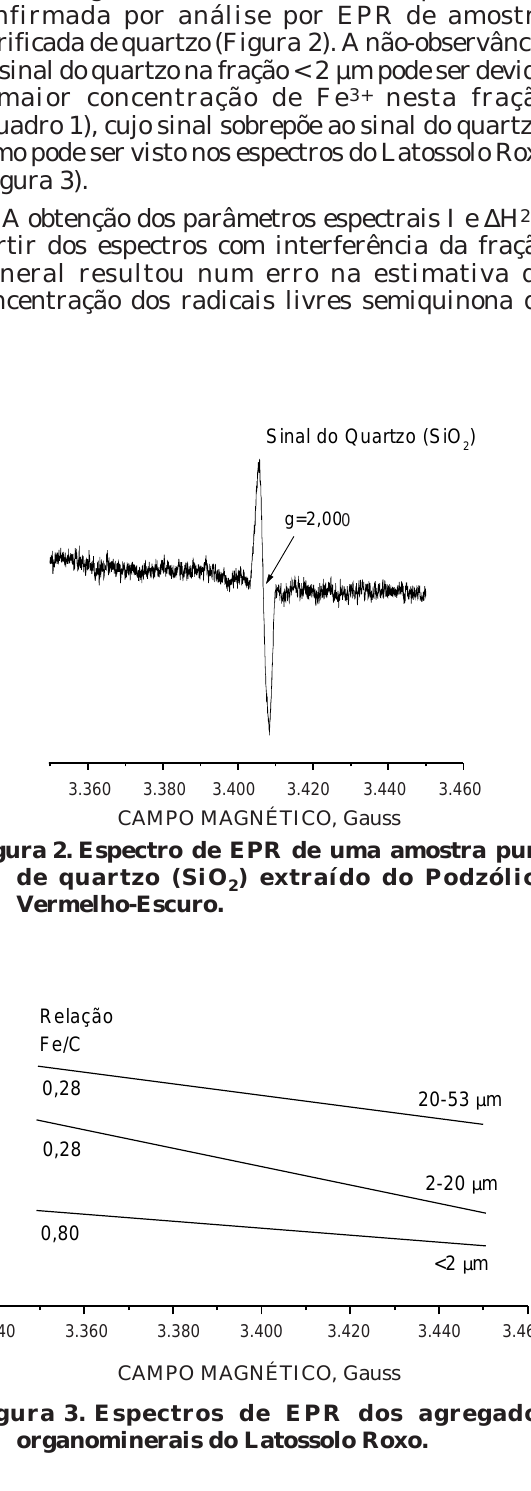
Figura 3. Espectros de EPR dos agregados organominerais do Latossolo Roxo.